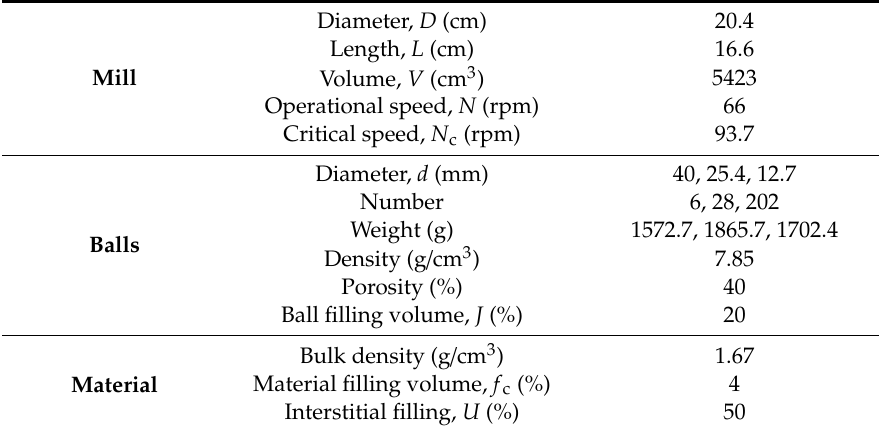
Table 2. Mill specification data and test